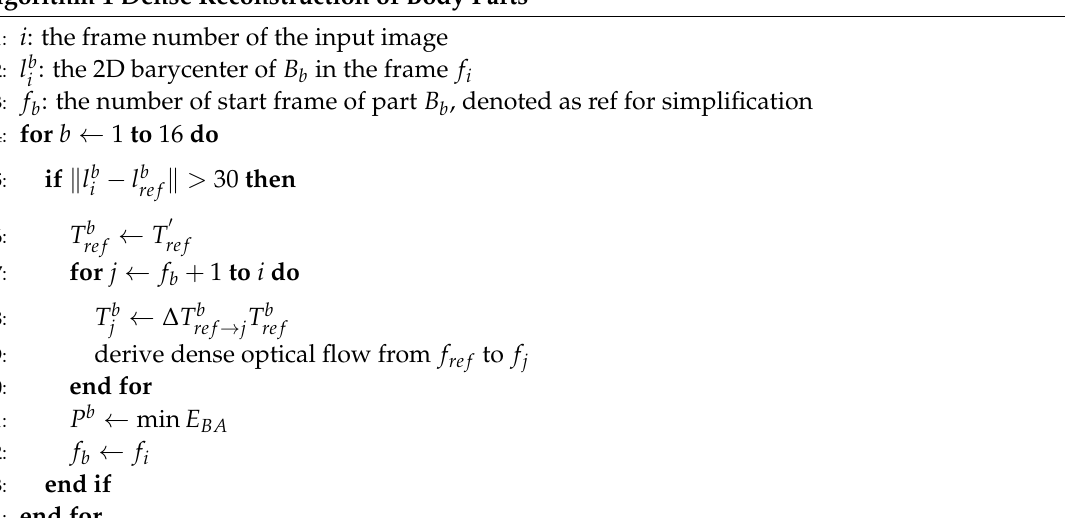
Algorithm 1 Dense Reconstruction of Body